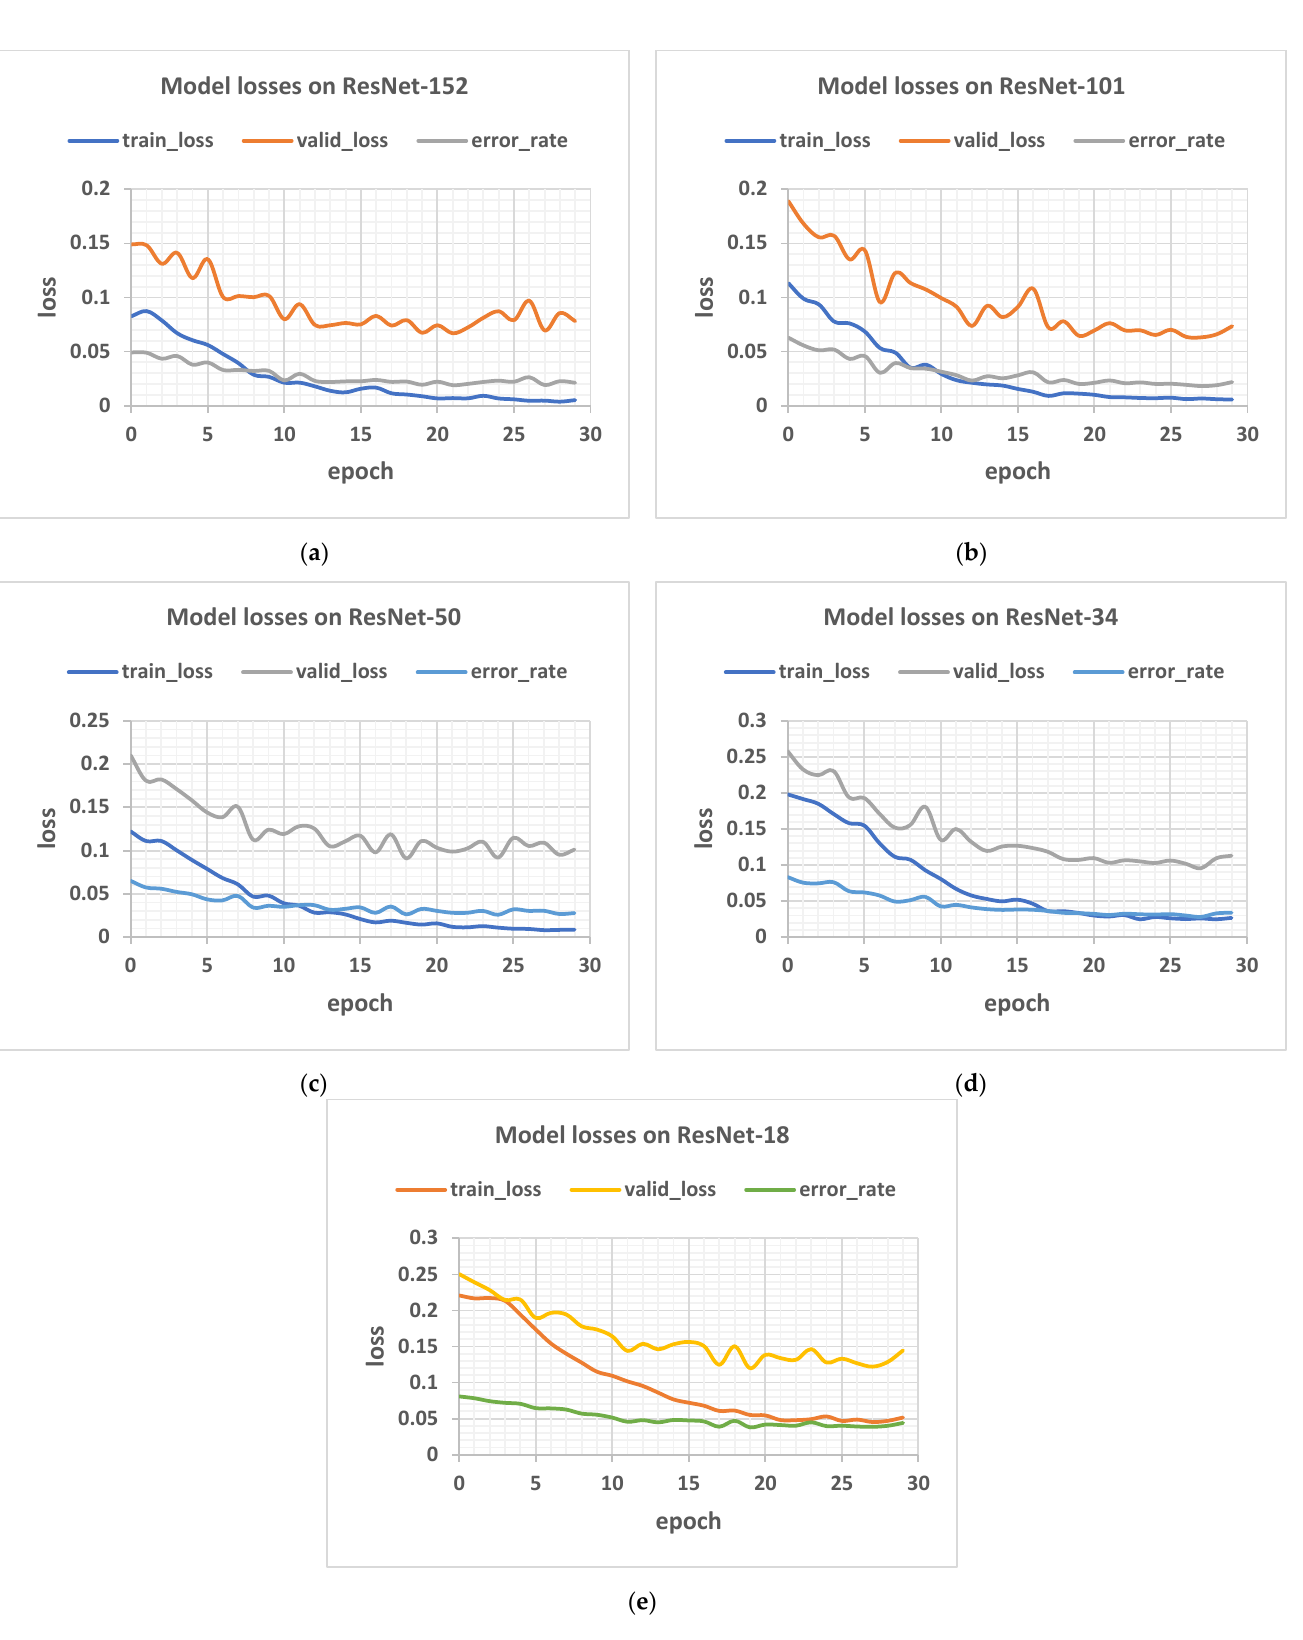
14 of 35 Figure 11. Showing the mistakes recorded by the model in our research: ( a ) showing the plot loss for ResNet-152; ( b ) showing the images the model predicted wrongly for ResNet-152, showing the predicted, ground truth, loss, and probability values. The network, though having an outstanding performance, was not 100% perfect. From Figure 11 above, classes that were wrongly recognized are displayed. The first im- age shows how the model predicted a late blight leaf as an early blight class. Table 4 shows the result of the network on various train-validation split ratios. The early blight and late blight diseased leaves had a very striking resemblance and as such, most of the wrong predictions recorded by our method happened to fall in between the two leaf classes. Ad- ditionally, some of the spots that could be found on leaves were so close that they could constitute a challenge in perfect distinction, giving rise to an imperfect recognition, even to the human eye. However, more research on fine-grained distinct images is needed to get to that point. Table 4. Results for various train-validation split ratios. Train Split (%) Validation Split (%)